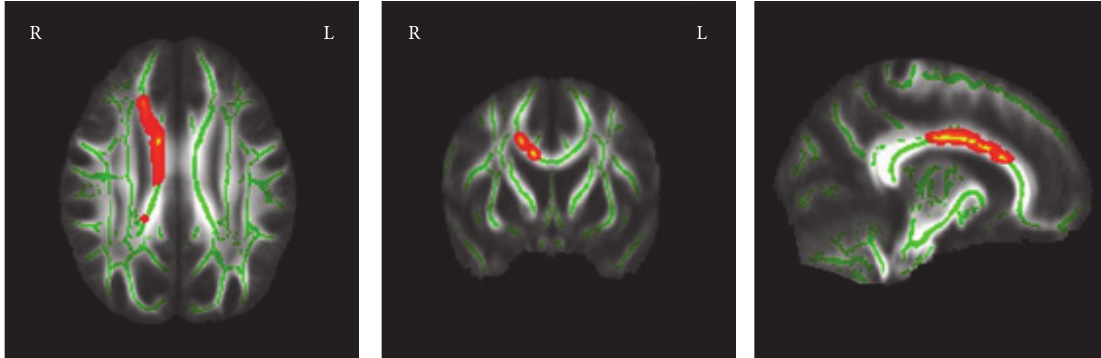
Figure 2: Differences in FA values between hydrocephalus group and control group. Significance was determined by t -test. Less FA values in hydrocephalus group than in control group are indicated by red/warm color. 𝑃 < 0.05 . L: left hemisphere. R: right hemisphere.